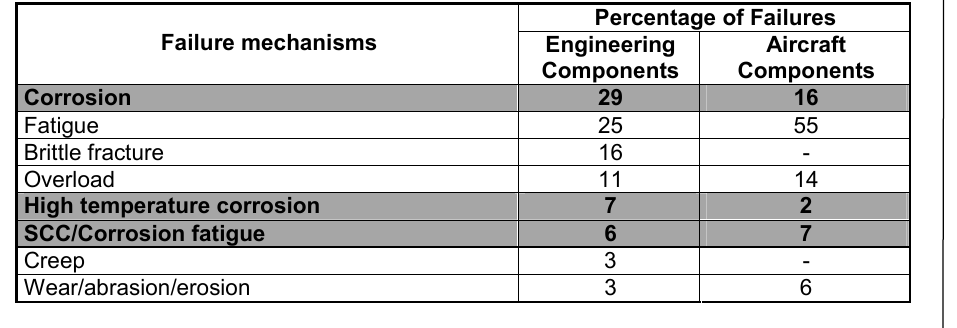
Table 1 – Frequency of failure mechanisms Таблица 1 – Частота механизмов отказов Tabela 1 – U č estalost pojave mehanizama otkaza